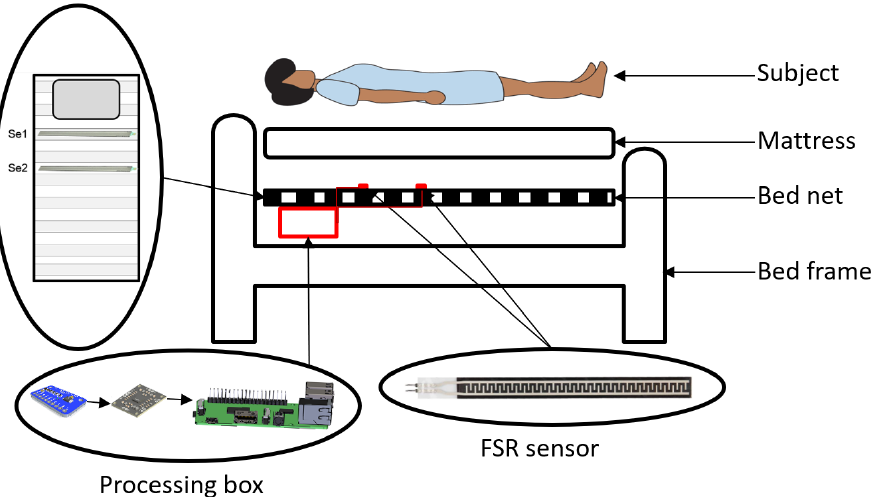
Figure 1. The approach offers a noninvasive, nonintrusive, and unobtrusive measurement of car- diorespiratory parameters. The sensors and system setup are located under the mattress and attached to the bed net without inconveniencing the